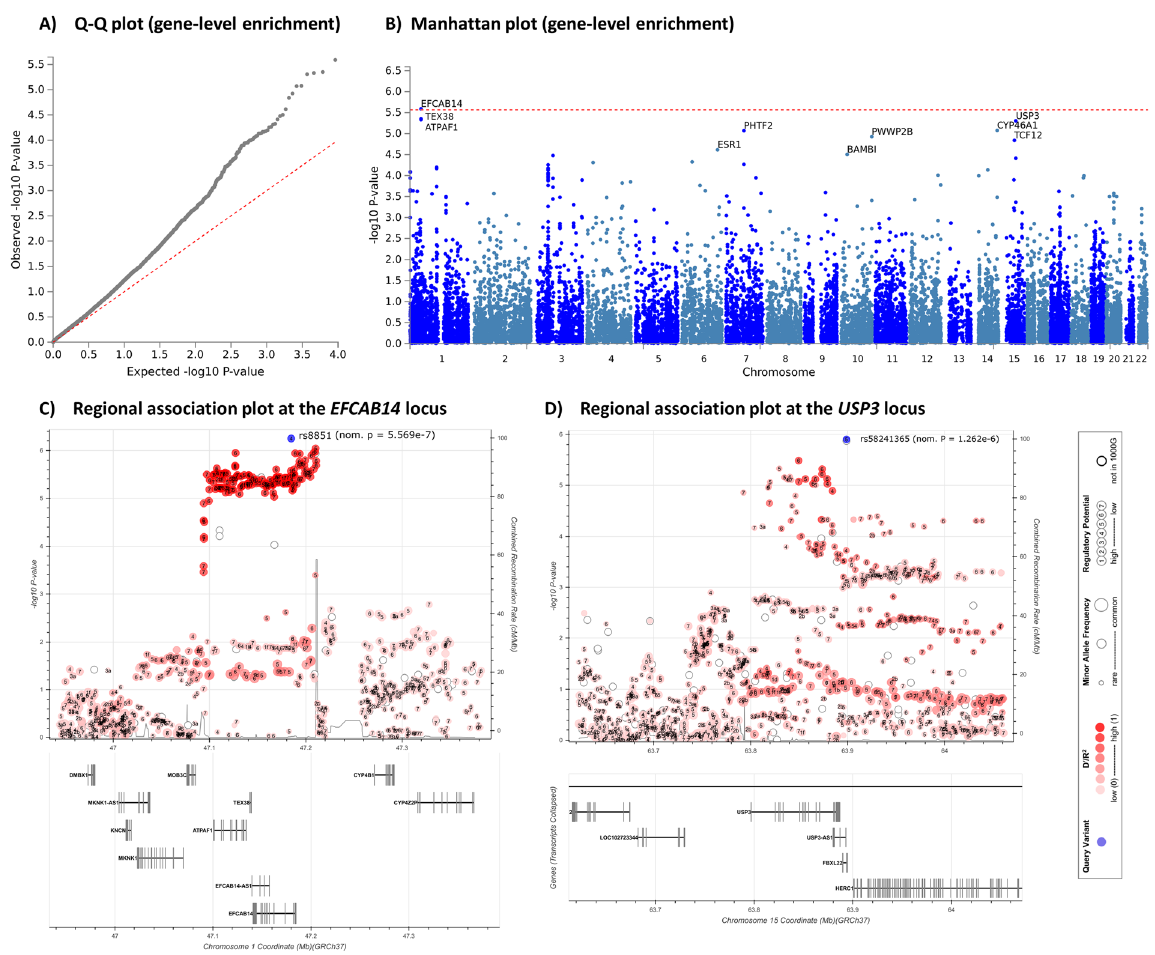
Figure 2. Gene-level enrichment analysis of the HIV-1 acquisition GWAS summary statistics identified a Bonferroni-significant susceptibility gene. ( A) The quantile-quantile (Q-Q) plot shows the high number of observed genes associated with HIV-1 acquisition, compared to the number of expected genes assuming a normal distribution (dotted red line). Generated using FUMA 17 . ( B) Gene-level Manhattan plot showing the novel susceptibility gene for HIV-1 acquisition on chromosome 1p33, EFCAB14 . Generated using FUMA 17 . ( C) Regional association plot demonstrating high linkage disequilibrium at the EFCAB14 locus. Generated using LDassoc 51 . ( D) Regional association plot at the second highest association signal with HIV-1 acquisition outside of chromosome 1. Generated using LDassoc 51